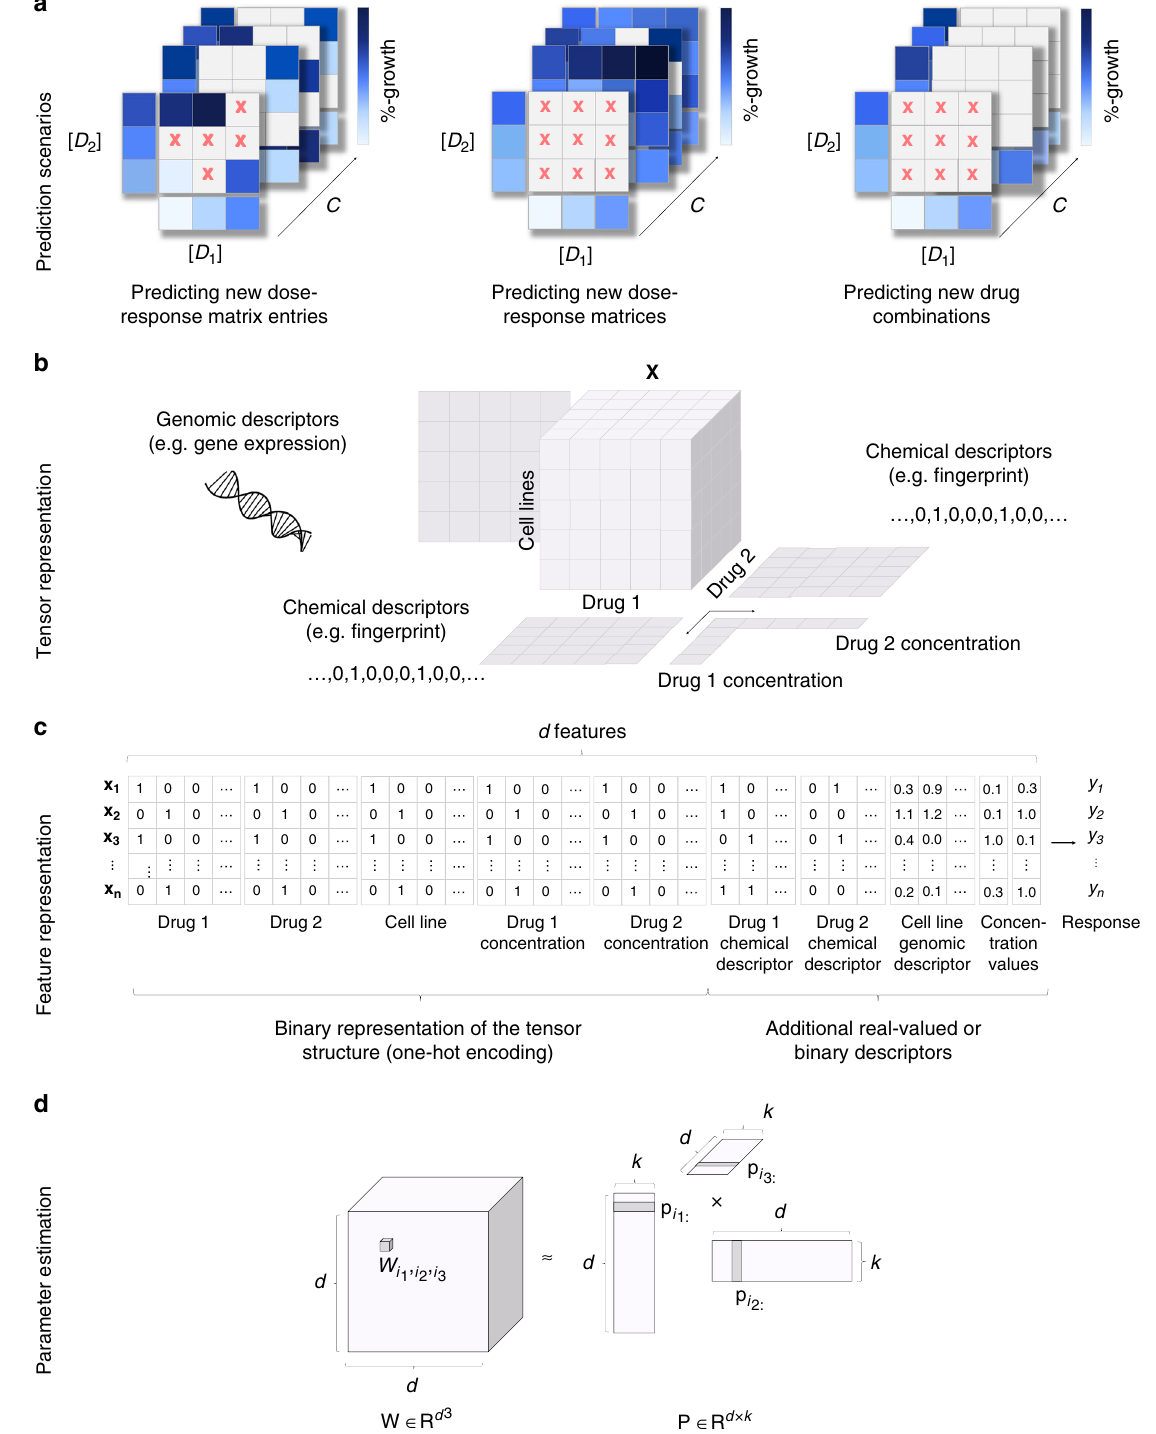
Fig. 1 Overview of the comboFM framework for the prediction of drug-dose combination effects. a Three prediction scenarios are considered: fi lling in missing entries in partially tested dose – response matrices, predicting a complete dose – response matrix in a new cell line, and making predictions for a completely new drug combination not tested so far in any cell line. b In each prediction scenario, the experimentally measured dose – response matrices are compiled into a fi fth-order tensor X indexed by drugs ( D 1 , D 2 ), drug concentrations ([ D 1 ], [ D 2 ]) and cell lines ( C ), and genomic and chemical descriptors are integrated into the prediction model. c The structure of the tensor underlying the drug combination dose – response matrix data is one-hot encoded into a single feature matrix together with the additional chemical and genomic descriptors. d The model parameters w i depicted) of features i of features and k is a hyperparameter de fi ning the rank of the